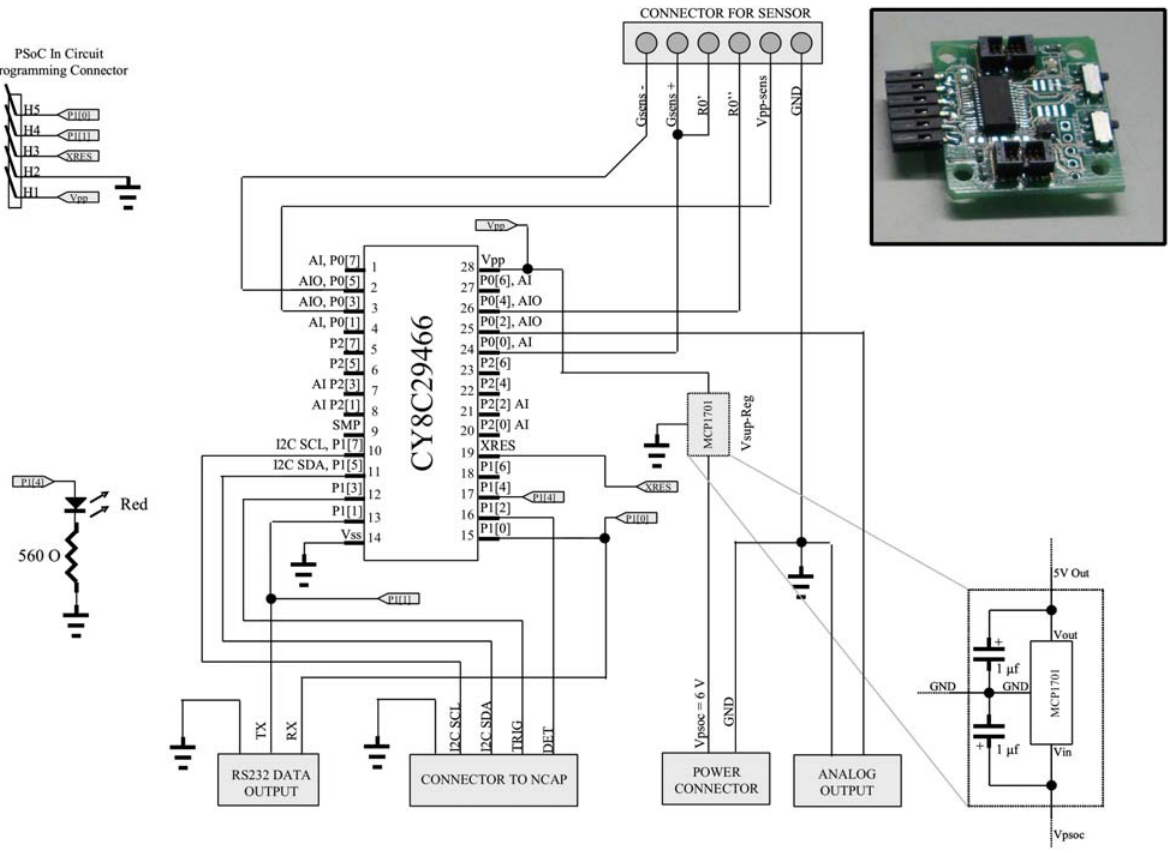
Figure 4. Schematic and the picture of the implemented UISI